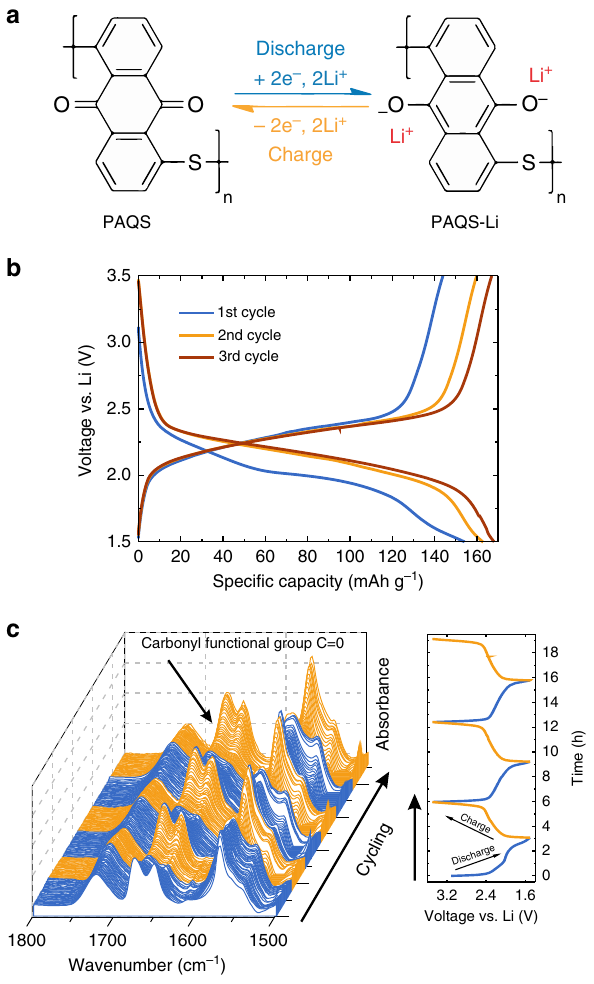
Fig. 2 Characterization of the Li – PAQS electrochemical mechanism through in operando ATR-IR. a Proposed electrochemical mechanism of PAQS in a Li – organic battery. b Discharge/charge cycles for the 1st, 2nd and 3th cycles of PAQS in the modi fi ed pouch cell with a Si wafer window at 50 mA g – 1 current density. c Corresponding ATR-IR spectra of the PAQS cathode during galvanostatic cycling in the region from 1800 to 1500 cm – 1 . Blue and orange spectra correspond to discharge and charge, respectively Fig. 3 The ATR difference spectra. a Spectrum of the PAQS and difference